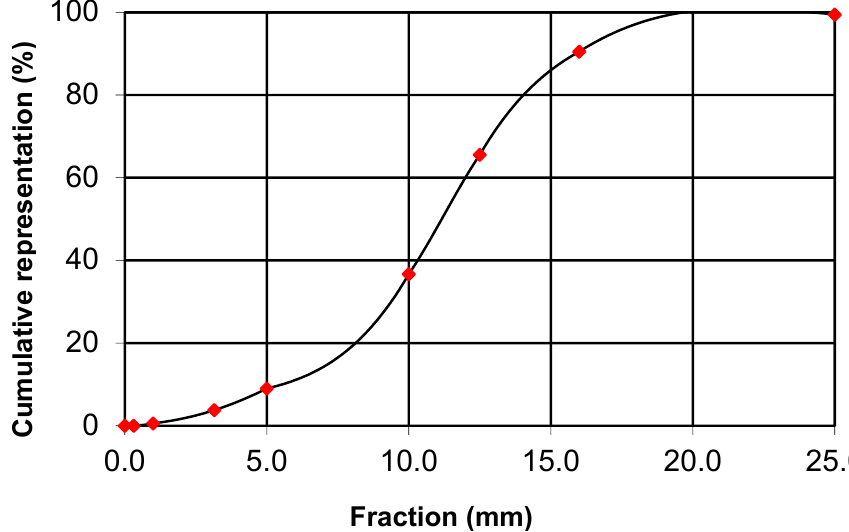
Figure 3. Fraction of crushed PUR foam.